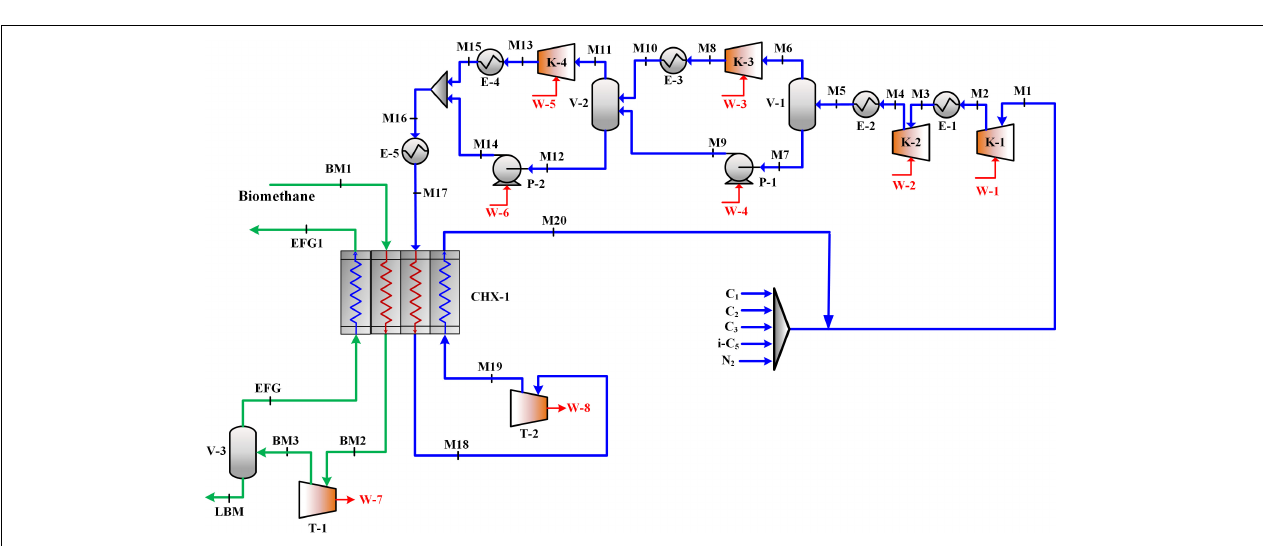
FIGURE 2 | Base case flow sheet of biomethane liquefaction by adopting the SMR process (Haider et al., 2020).